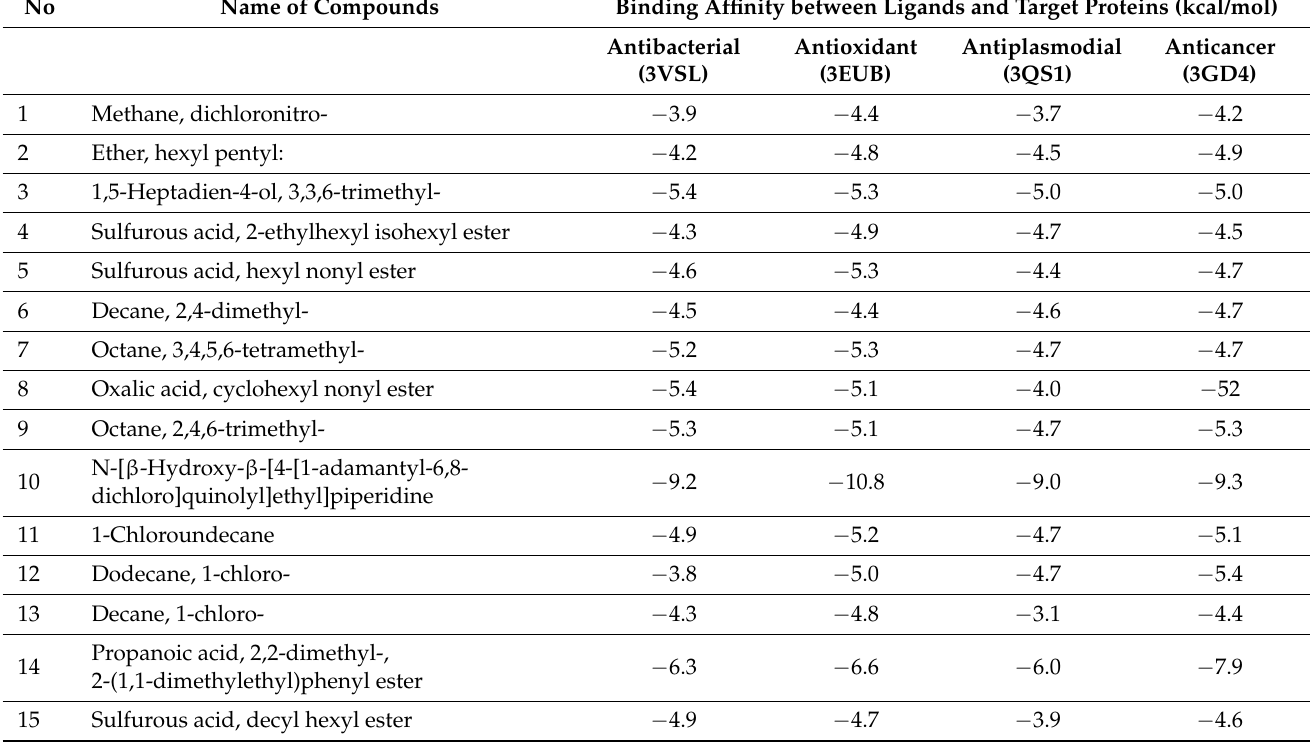
Table 2. Binding affinity of identified compounds to selected target proteins. Nd: not detected.